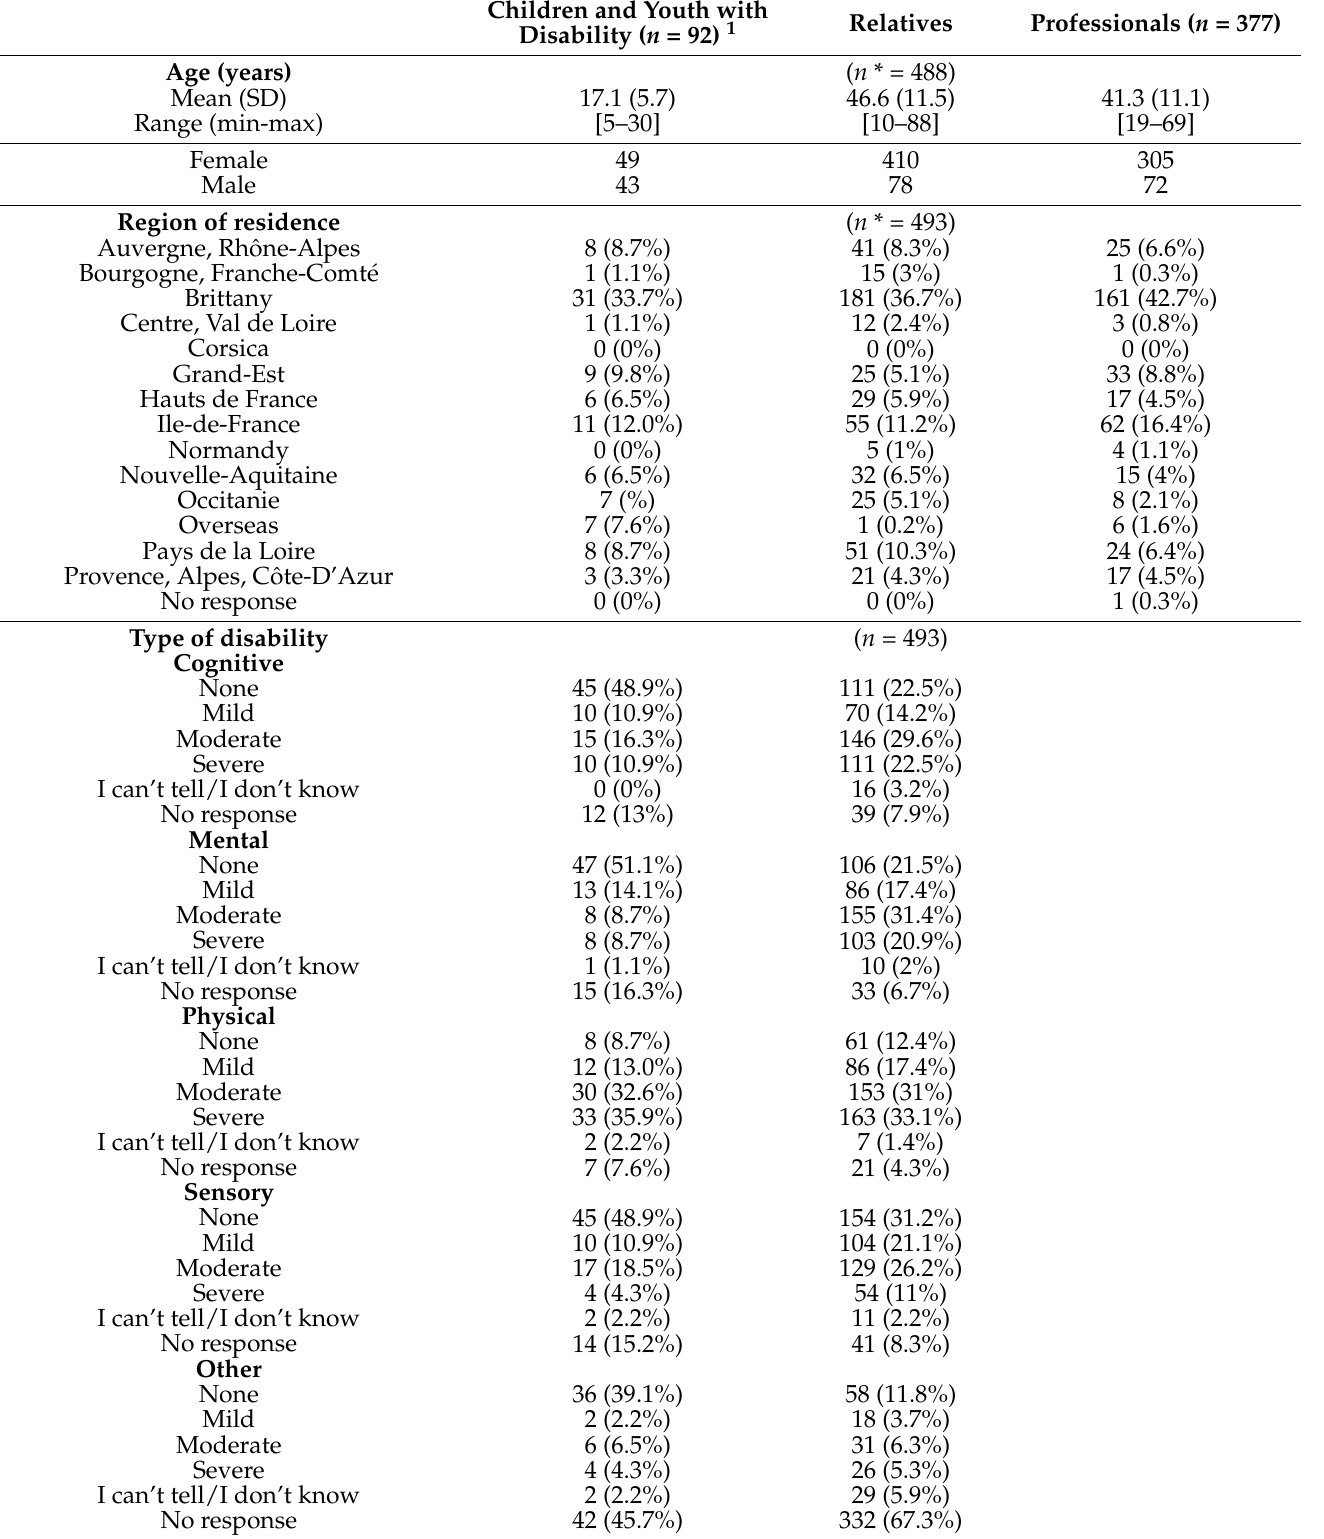
Table 1. Description of the